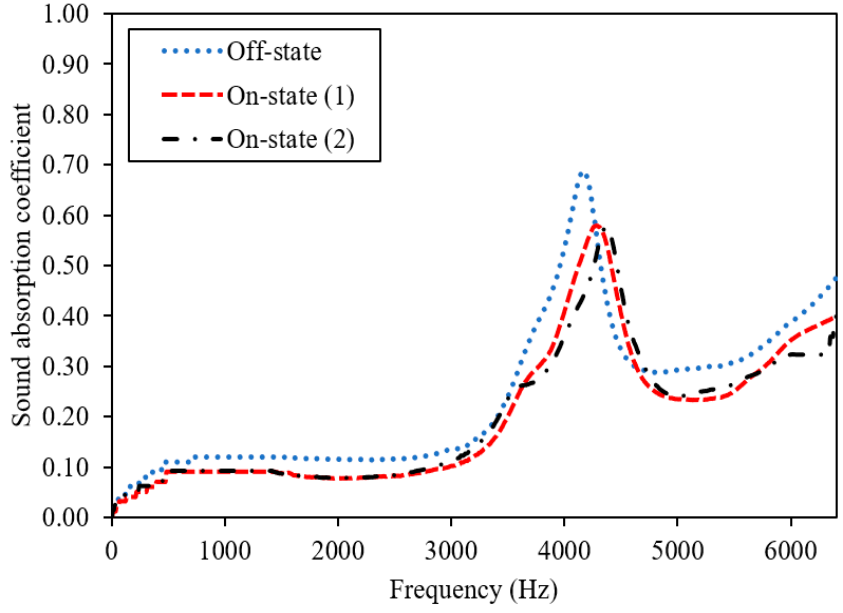
Figure 7. Dynamic sound absorption of MR foam with 35 wt.% CIPs (Sample B).